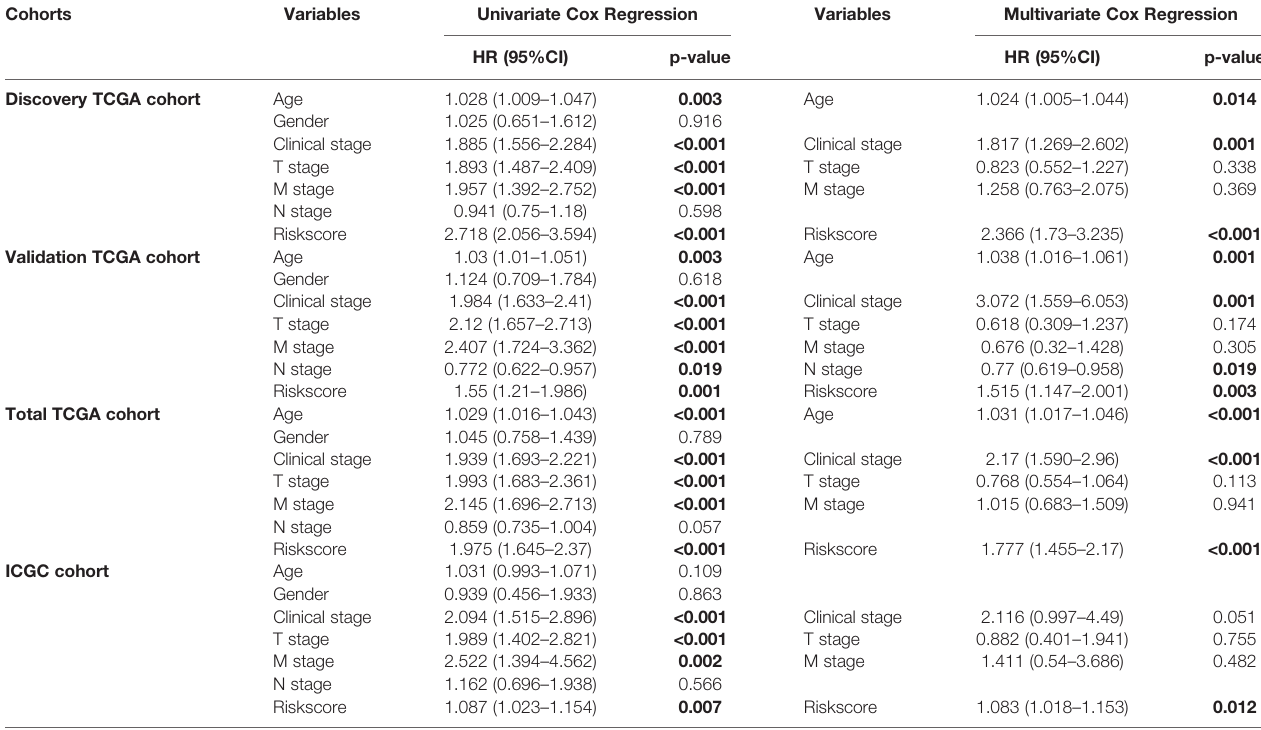
The bold values indicated the correspondence variable was signi fi cant difference in Univariates Cox regression or Multivariate Cox regression